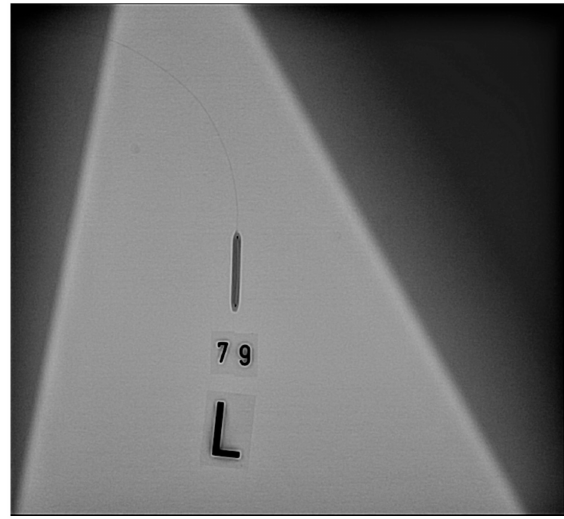
Figure 2. Balloon without